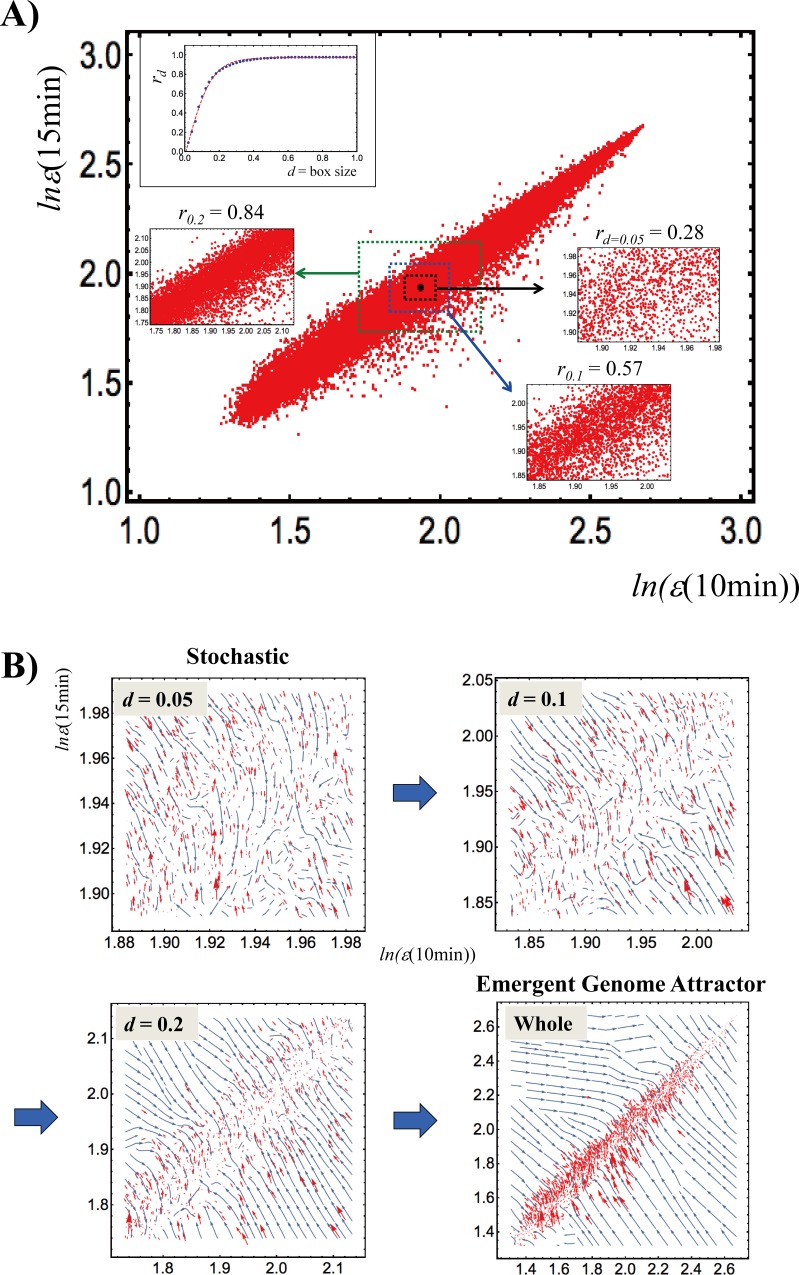
Transition of gene expression from a stochastic to a genome-wide attractor profile.A) Plot shows the whole expression profiles at 10min (x-axis) and 15min (y-axis) for the HRG response in MCF-7 cells. A box is constructed from the center of mass (i.e., average of whole expression), (CM(10min), CM(15min)) (black dot); a box contains gene expression within the range from CM(tj)—d to CM(tj) + d with a variable box size, d. To highlight the scaling of the Pearson correlation with box size d, rd for d = 0.05, 0.1 and 0.2 are reported. The plot in the upper left corner shows that, between gene expression profiles, the Pearson correlation rd follows a tangent hyperbolic function: rd = 0.97 ⋅ tanh(6.79 ⋅ d − 0.039) (p<10−4), which reveals a critical transition in the correlation development. B) Stream plots for the box sizes in Panel A. These plots are generated from the vector field values {Δxi, Δyi} at expression points {xi(10min), xi(15min)}, where Δxi = xi(15min)—xi(10min), Δyi = xi(20min)—xi(15min), and xi(tj) is the natural log of the ith expression: xi(tj) = ln(εi(tj)) at t = tj (tj = 10min or 15min; i = 1,2,.., N = 22,277). Blue lines represent streamlines and red arrows represent vectors at a specified expression point (plot every 2nd, 6th 10th and 20th point for d = 0.05, 0.1, 0.2, and the whole set, respectively). When we move from a small number of genes to the whole set, gene expression shifts from a stochastic to a genome-wide attractor profile.